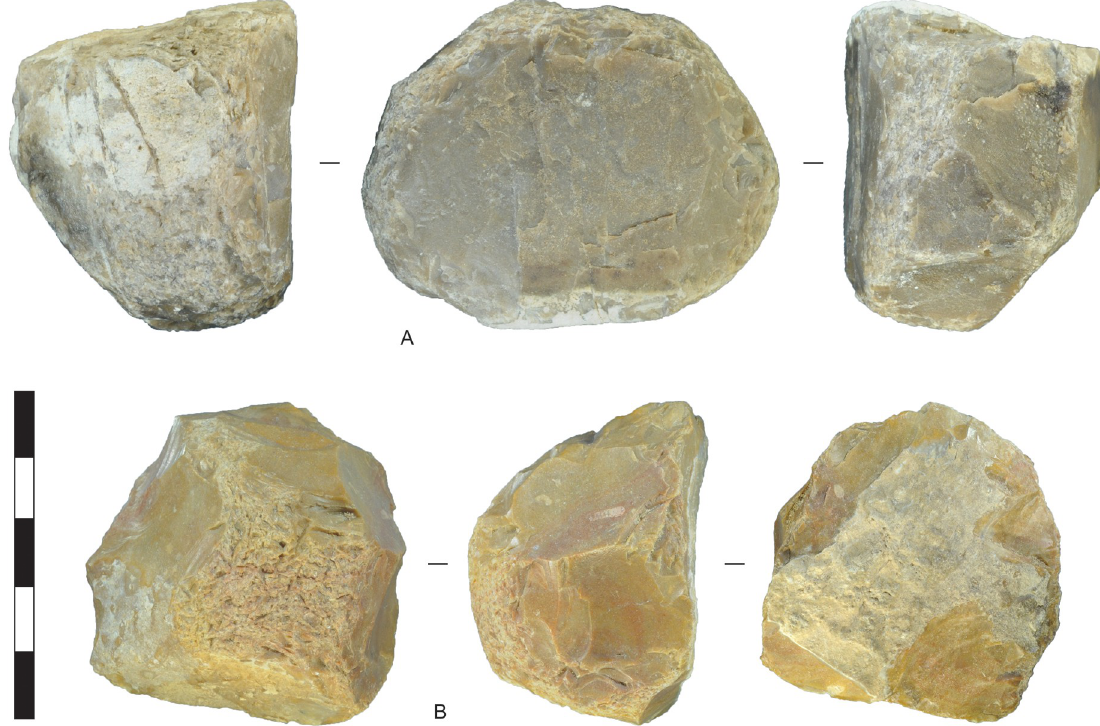
Fig 8. Hammerstones, Horizon IV, Saruq al-Hadid. (A) Dolomite hammerstone with wear facets around the perimeter. (B) Chert hammerstone with a wear facet on one face. The hammerstone was shaped by percussion flaking prior to use as a hammer. From contexts 2446 (A) and 2006 (B). Scale bar 50